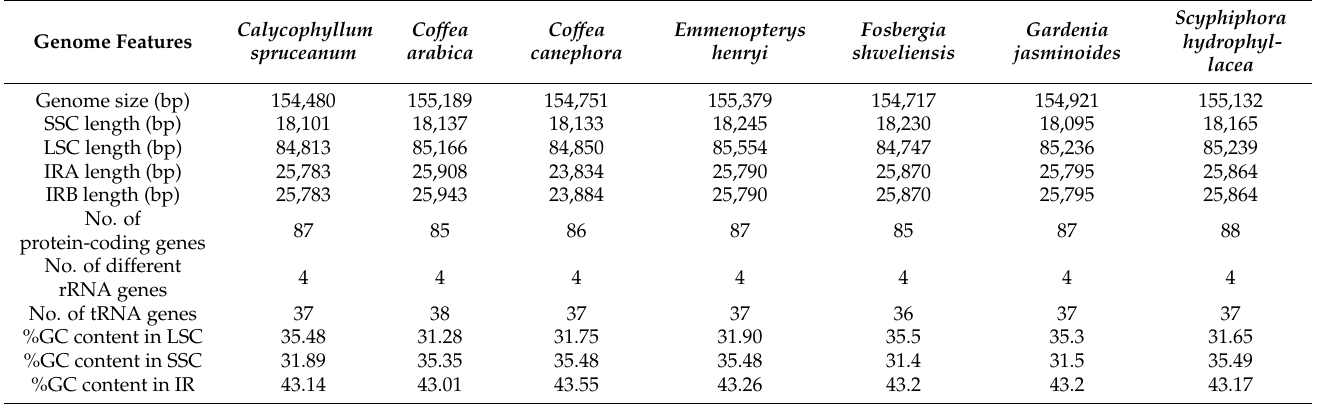
Table 1. Features of the chloroplast genomes of C. spruceanum and six Ixoroideae